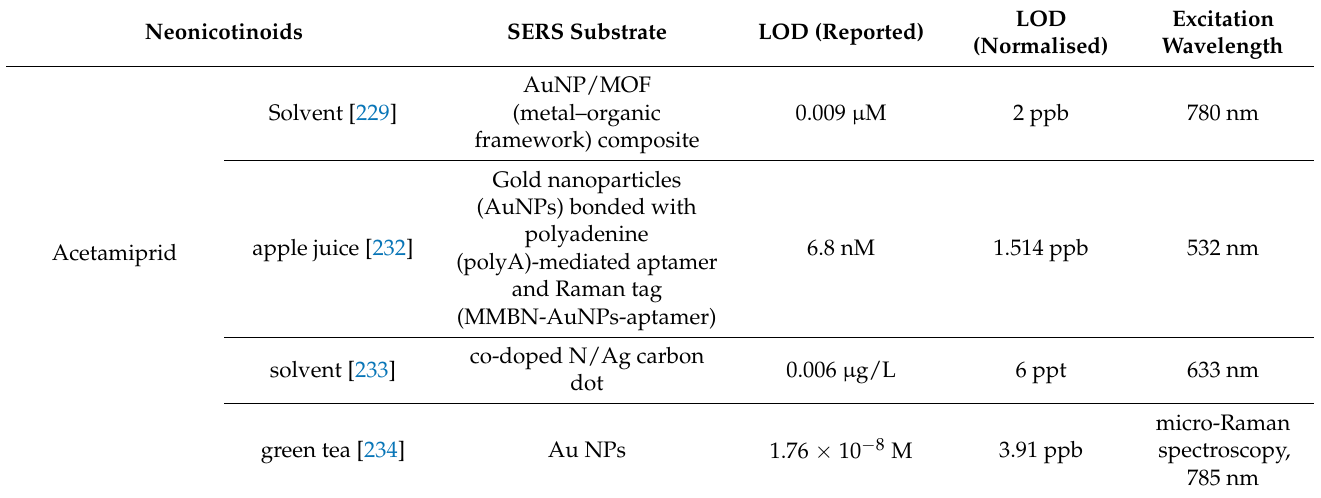
Table 3. Neonicotinoids detection by SERS in food industry and environment monitoring.